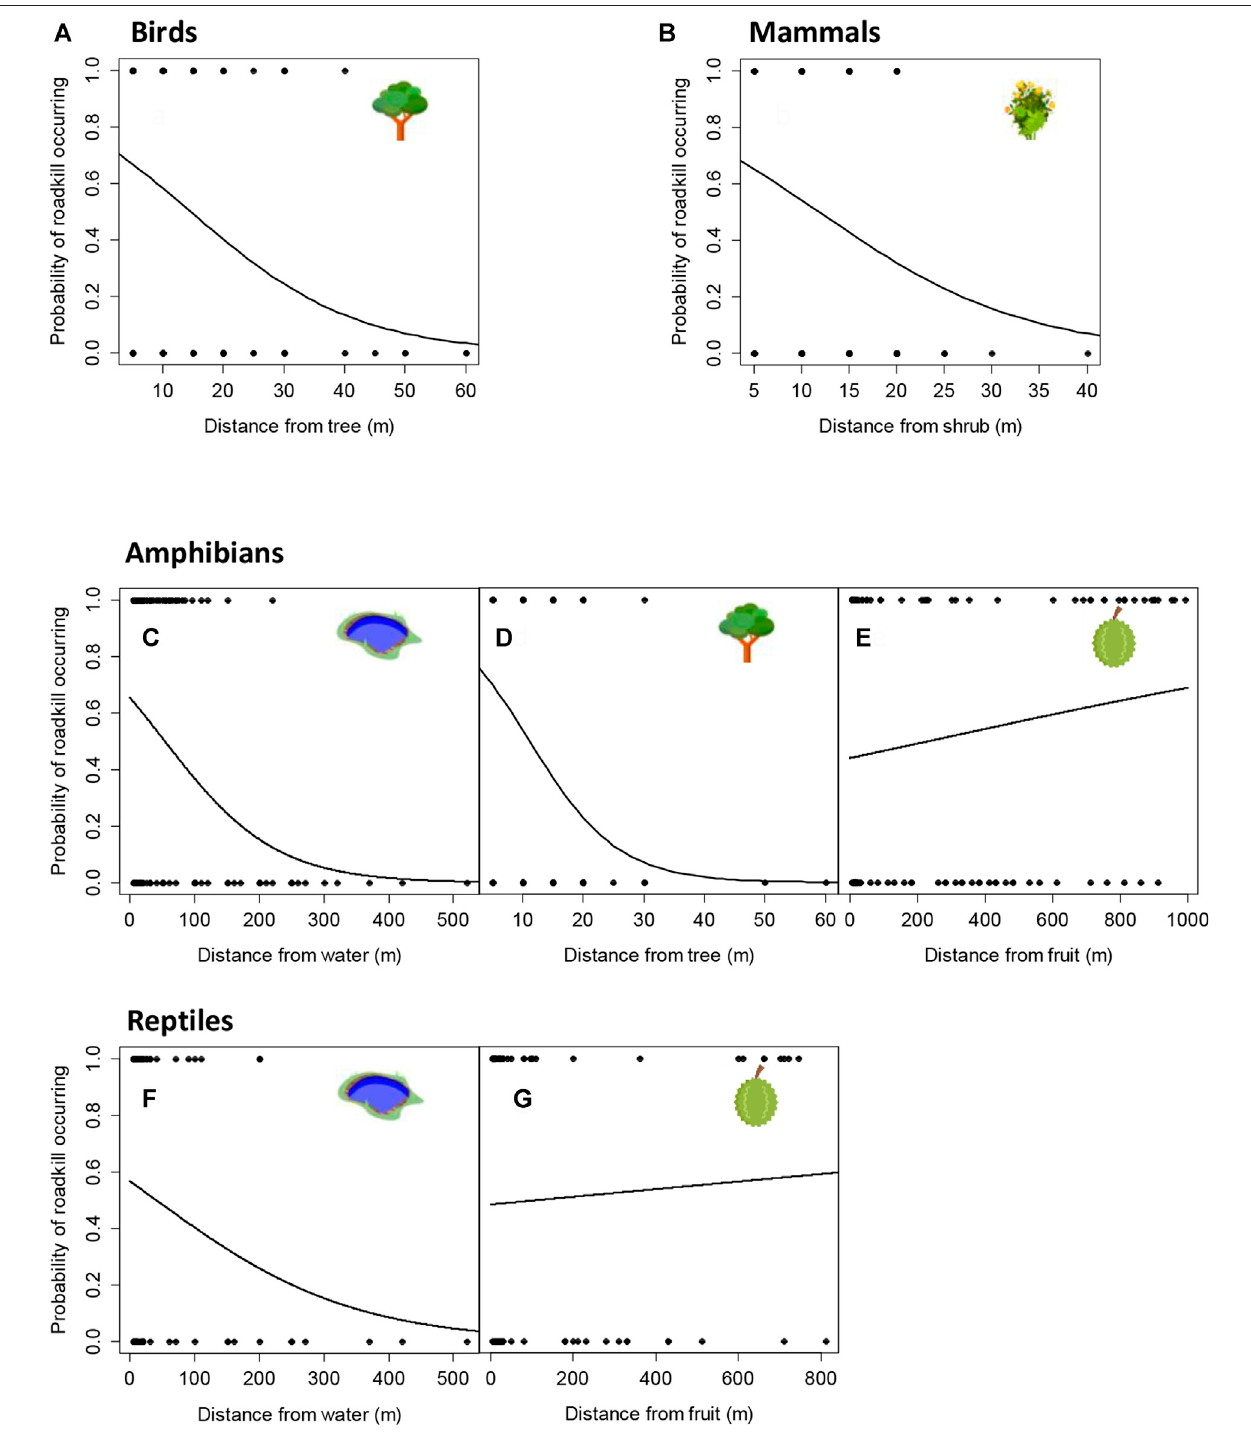
FIGURE 3 | Probability that a bird roadkill will occur with increasing distance from the nearest tree (A) ; that a mammal roadkill will occur with increasing distance fromthenearestshrub (B) ;thatanamphibianroadkillwilloccurwithincreasingdistancefromthenearestwaterbody (C) ,tree (D) orfruittree (E) ;andthatareptileroadkill will occur with increasing distance from the nearest water body (F) or fruit tree (G) .